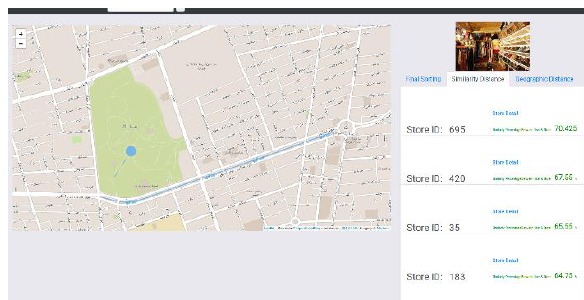
Figure 5- A view of the website that illustrates the